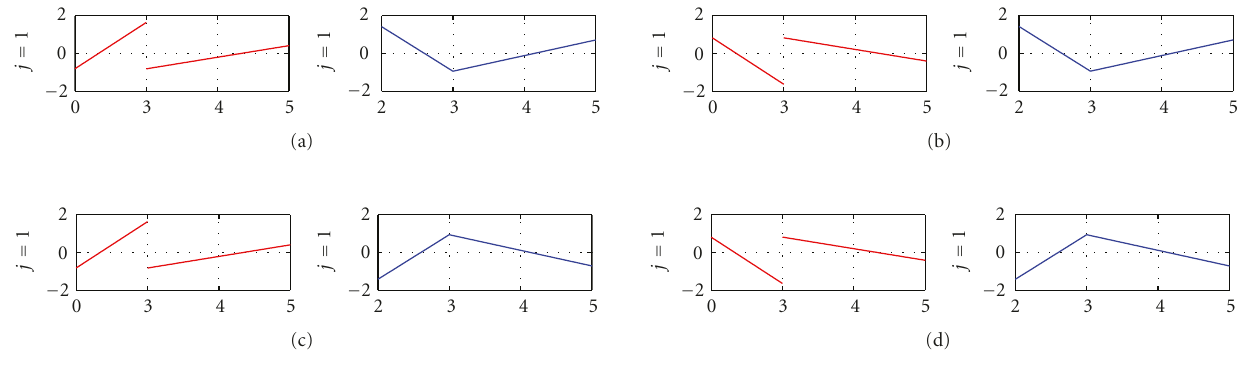
Figure 6: Four orthonormal linear wavelet bases at resolution level j = 1.